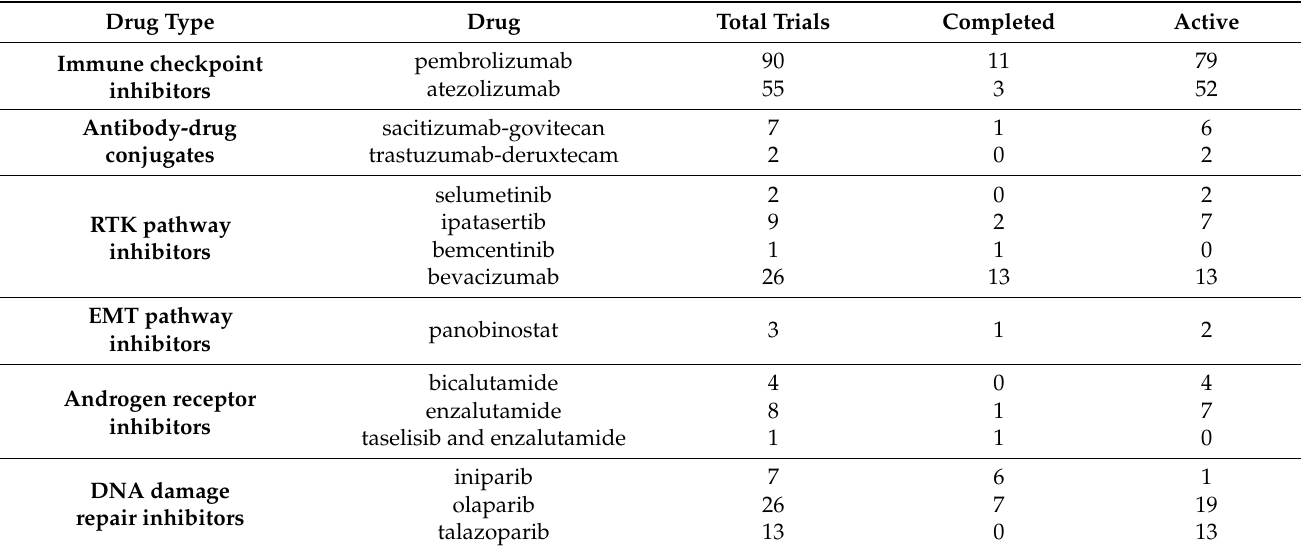
Table 1. Current Immunotherapy Clinical